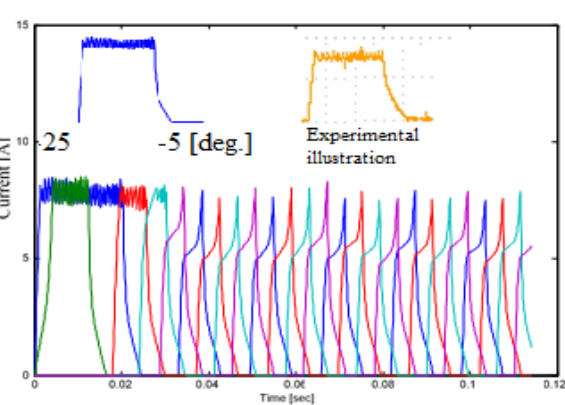
Fig. 7. Phase current waveform of 4-phase machine including the control i.e., voltage PWM